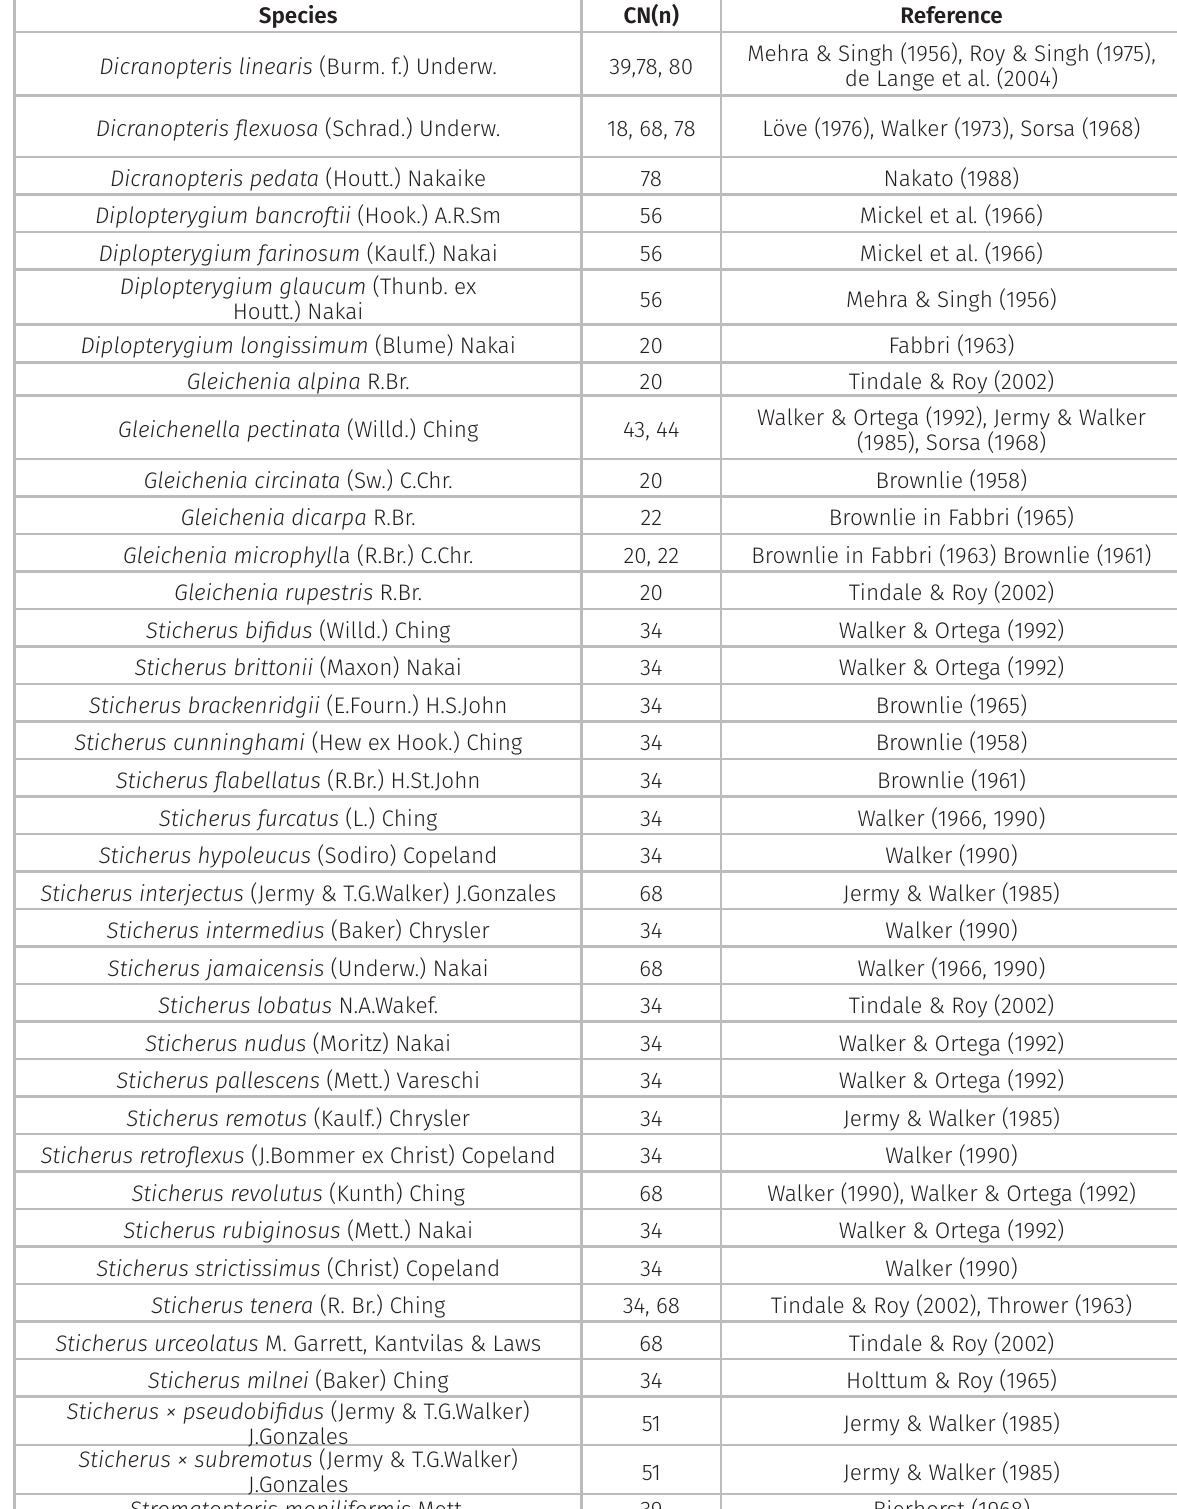
Table III. Chromosome numbers in Gleicheniaceae. CN= Chromosome